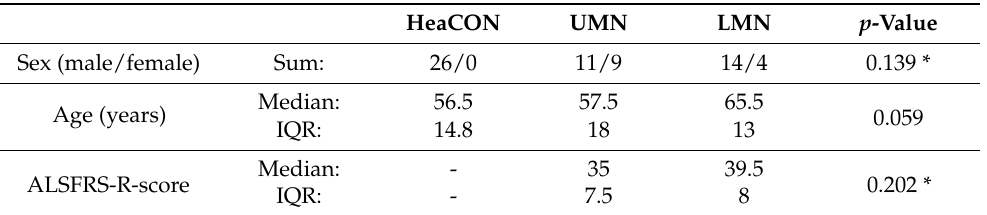
Table 2. Demographic and clinical data of the three study groups including results from statistical x 2